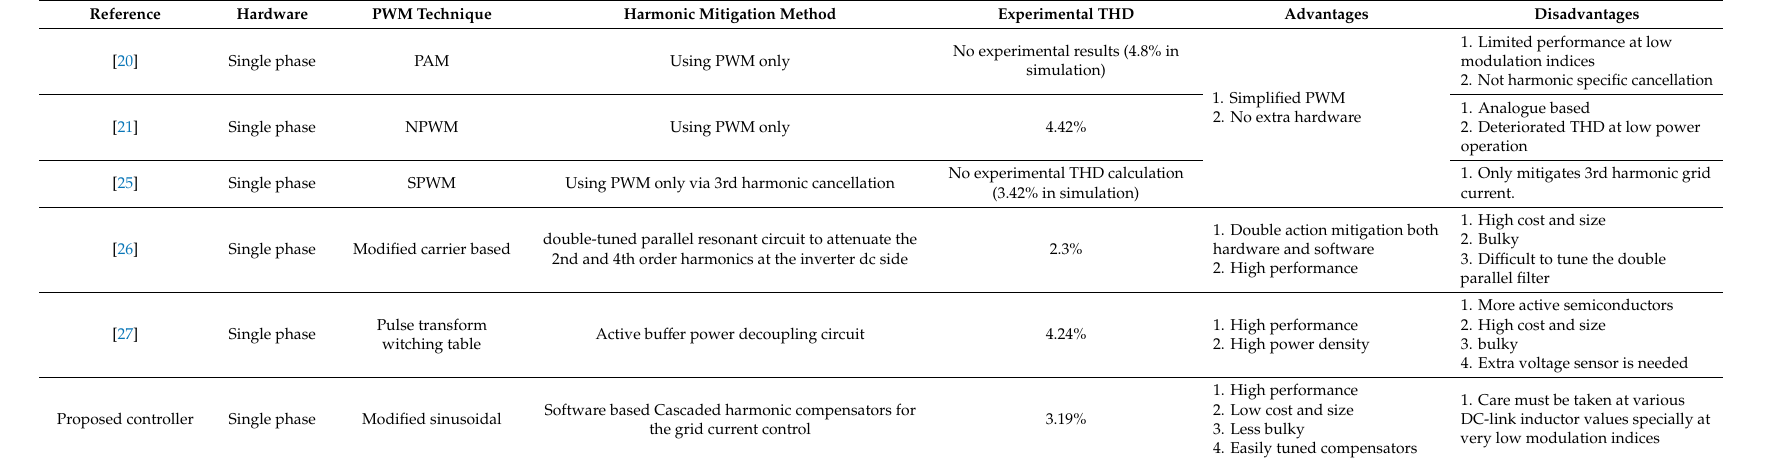
Table A1. Comparison table between the proposed controller and other competitors in